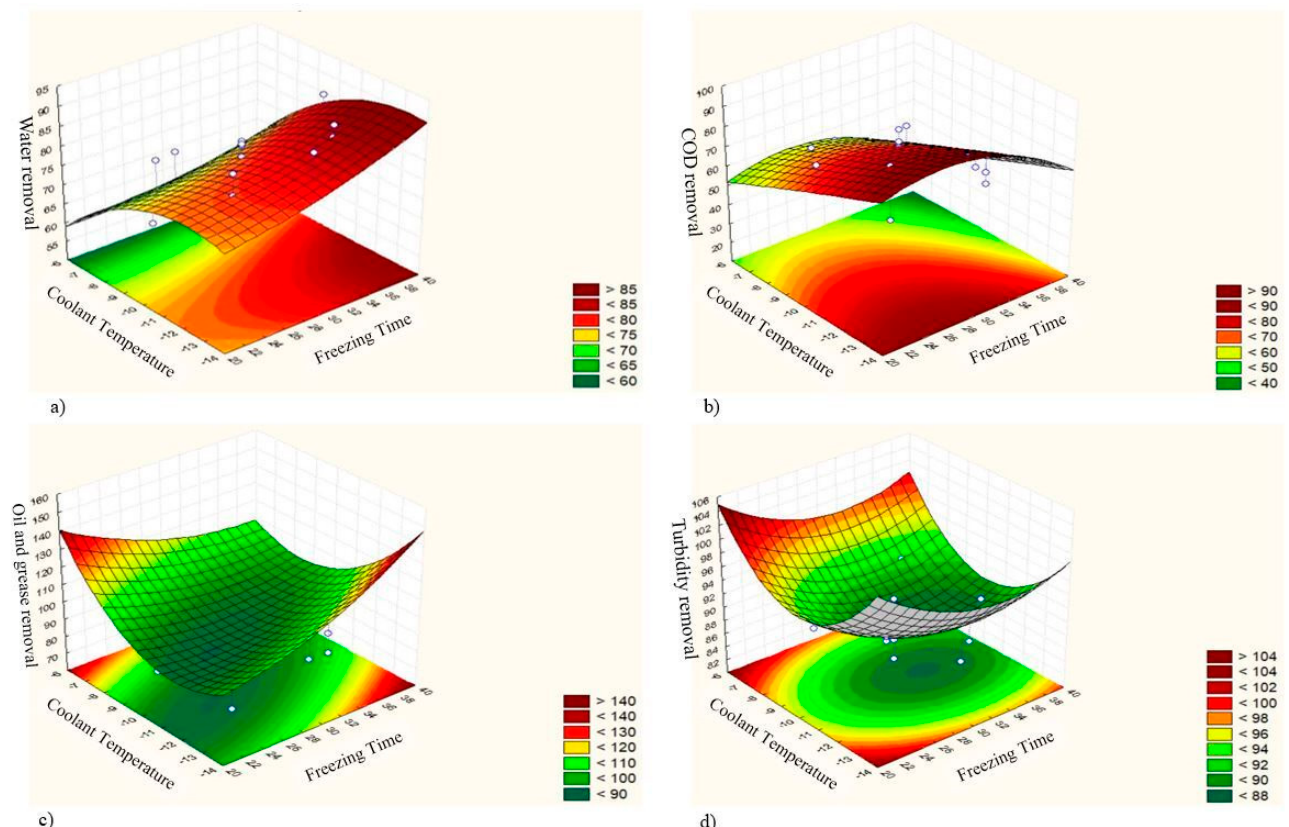
Figure 5. 3D surface plot of ( a ) water removal ( b ) chemical oxygen demand (COD) removal ( c ) oil and grease removal ( d ) turbidity removal as a function of coolant temperature and freezing time.